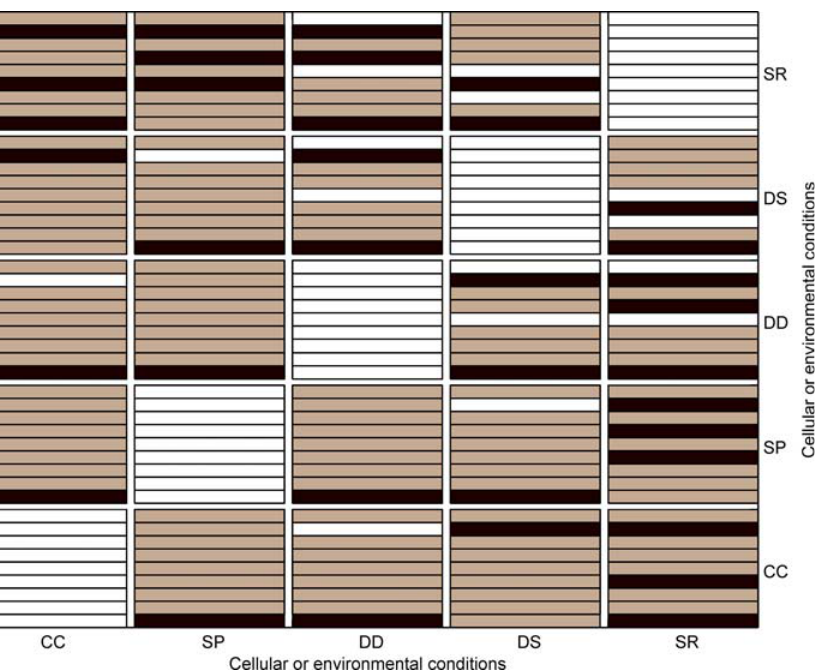
Figure 4. Dynamic Shifts in the SPPs (3-Vertex Level) of Nine THubs The bars represent the THubs YDL056W, YMR043W, YBR049C, YJR060W, YIL122W, YKL043W, YKL112W, YEL009C, and YLR013W (top to bottom). A black bar indicates that the THub showed a significant change in its SPP between the two conditions, whereas a white bar indicates a significant lack of change in the SPP of the THub. The assessment of the statistical significances was made by comparing to a set of random networks as described in Protocol S1. DOI: 10.1371/journal.pcbi.0020047.g004